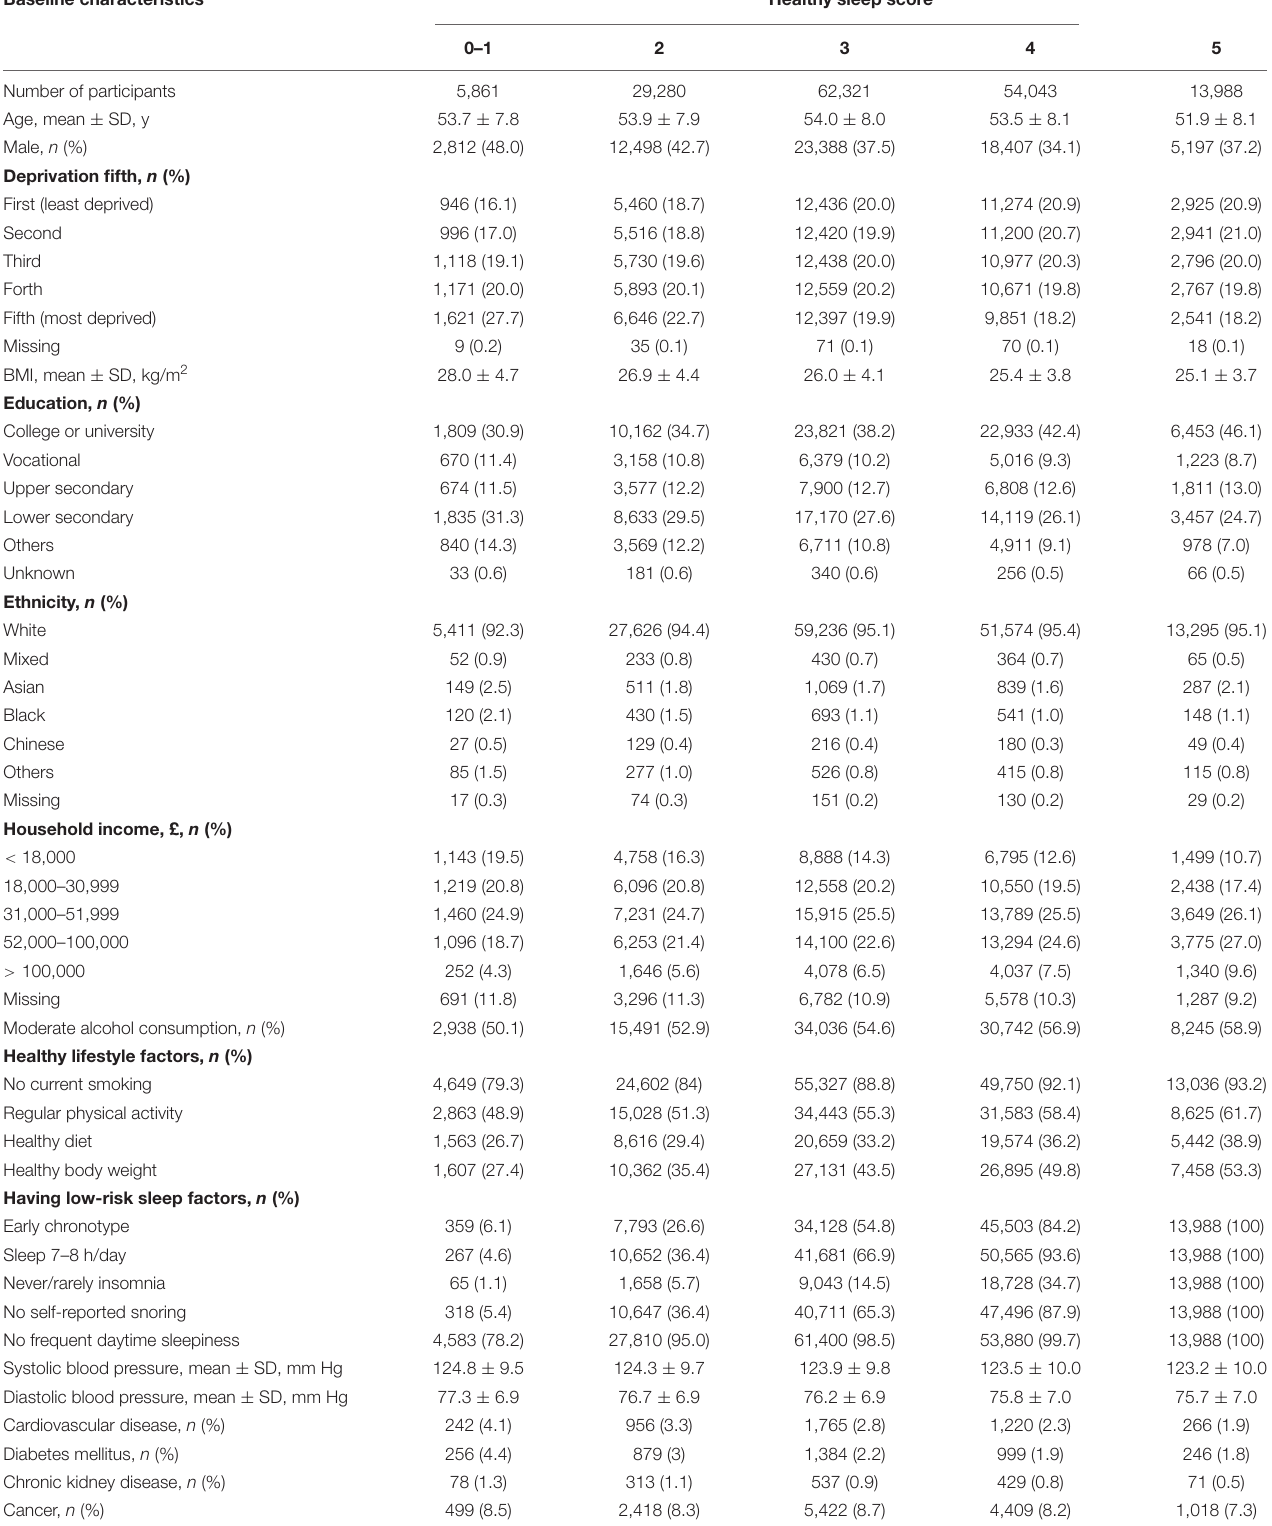
TABLE 1 | Baseline characteristics of 165,493 participants in UK Biobank